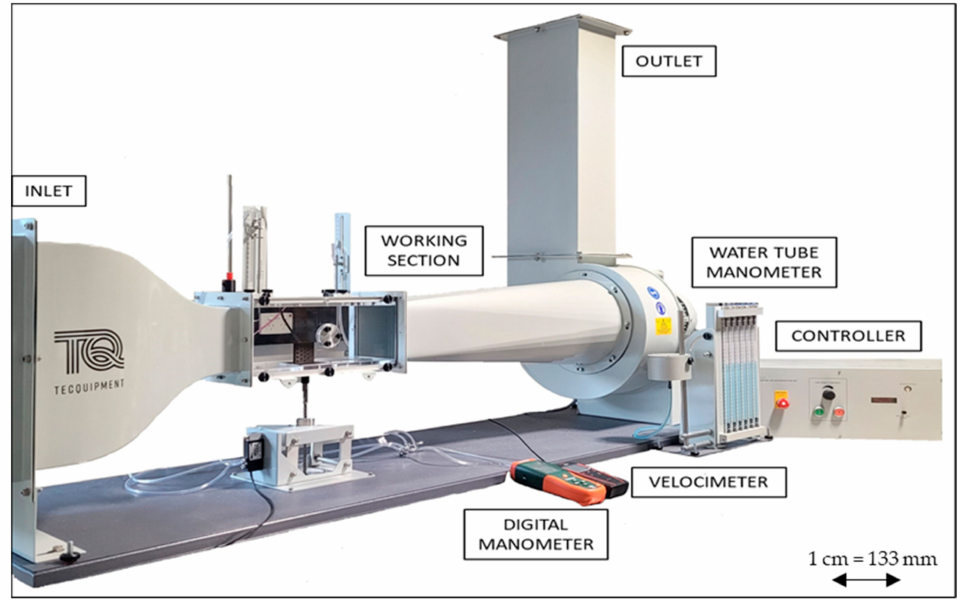
Figure 2. AF1125 subsonic wind